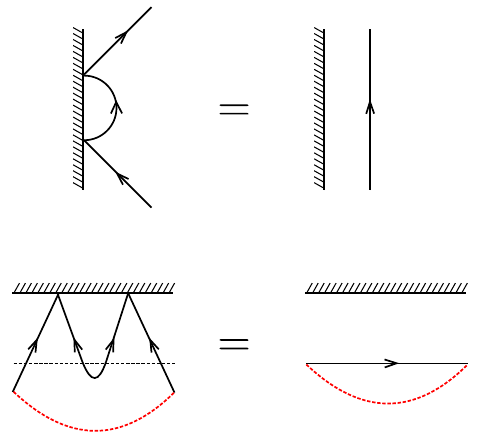
Figure 25 . The boundary unitarity and the decoupling condition. By cutting the lower (cid:12)gure along the black dashed line, we can see that the boundary unitarity in the re(cid:13)ection picture (the upper (cid:12)gure) is equivalent to the decoupling condition for a pair of particle-antiparticle pairs in the form factor picture (the lower (cid:12)gure). The extra red dashed curve denotes the contraction with (cid:14) A Boundary unitarity =